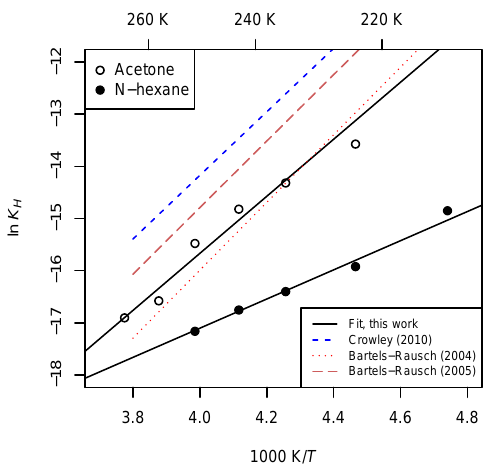
Figure 4. K H as a function of T for experiments using an untreated column and methylsilyl-deactivated columns coated with aged ice. Experiments conducted with the same prepared column are marked by the same color.